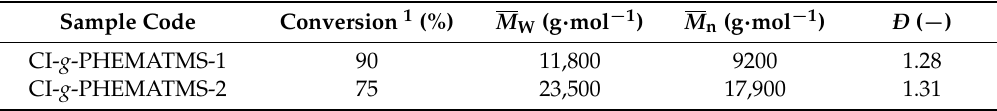
Table 2. Results of CI- g -PHEMATMS particle syntheses.